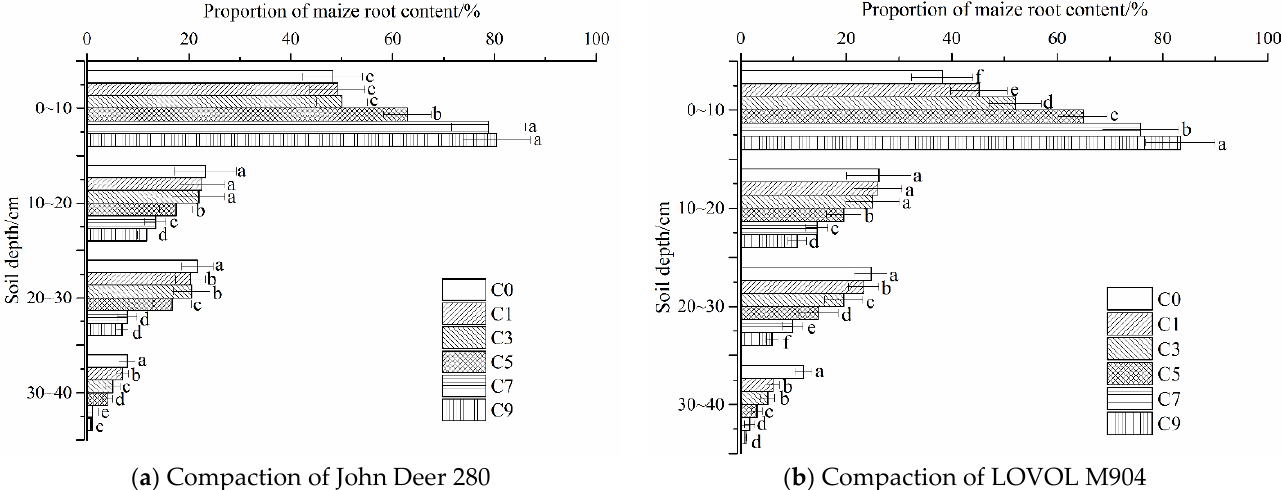
Figure 9. Spatial distribution of maize roots under different loads and tractor passes. Different lowercase letters indicate significant differences among treatments ( p < 0.05).